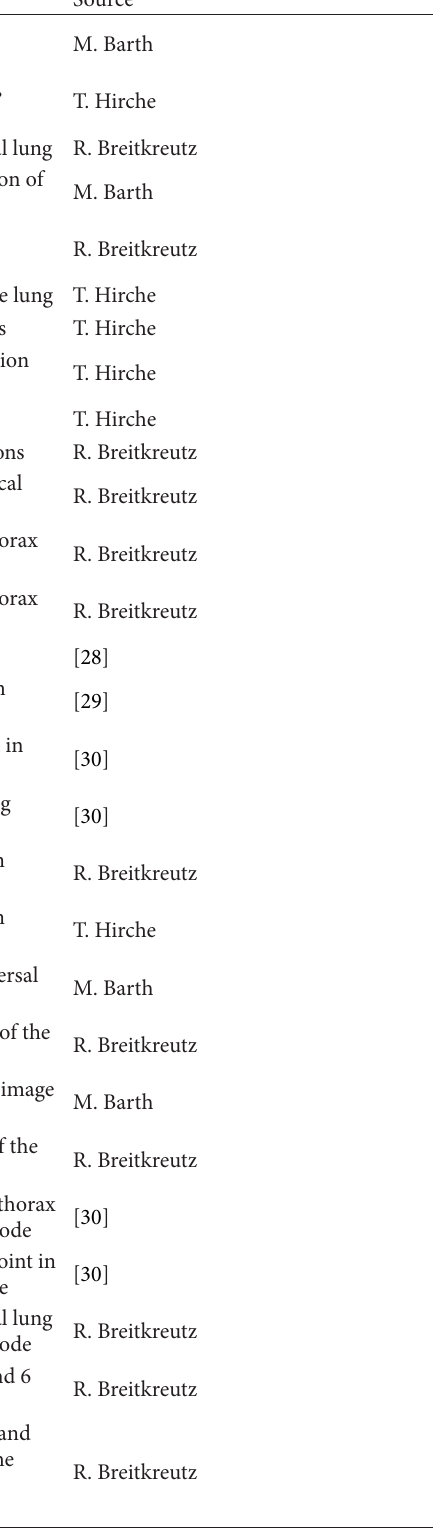
Table 1: Source index of sonographic films and still images used in the online e-learning program modules.